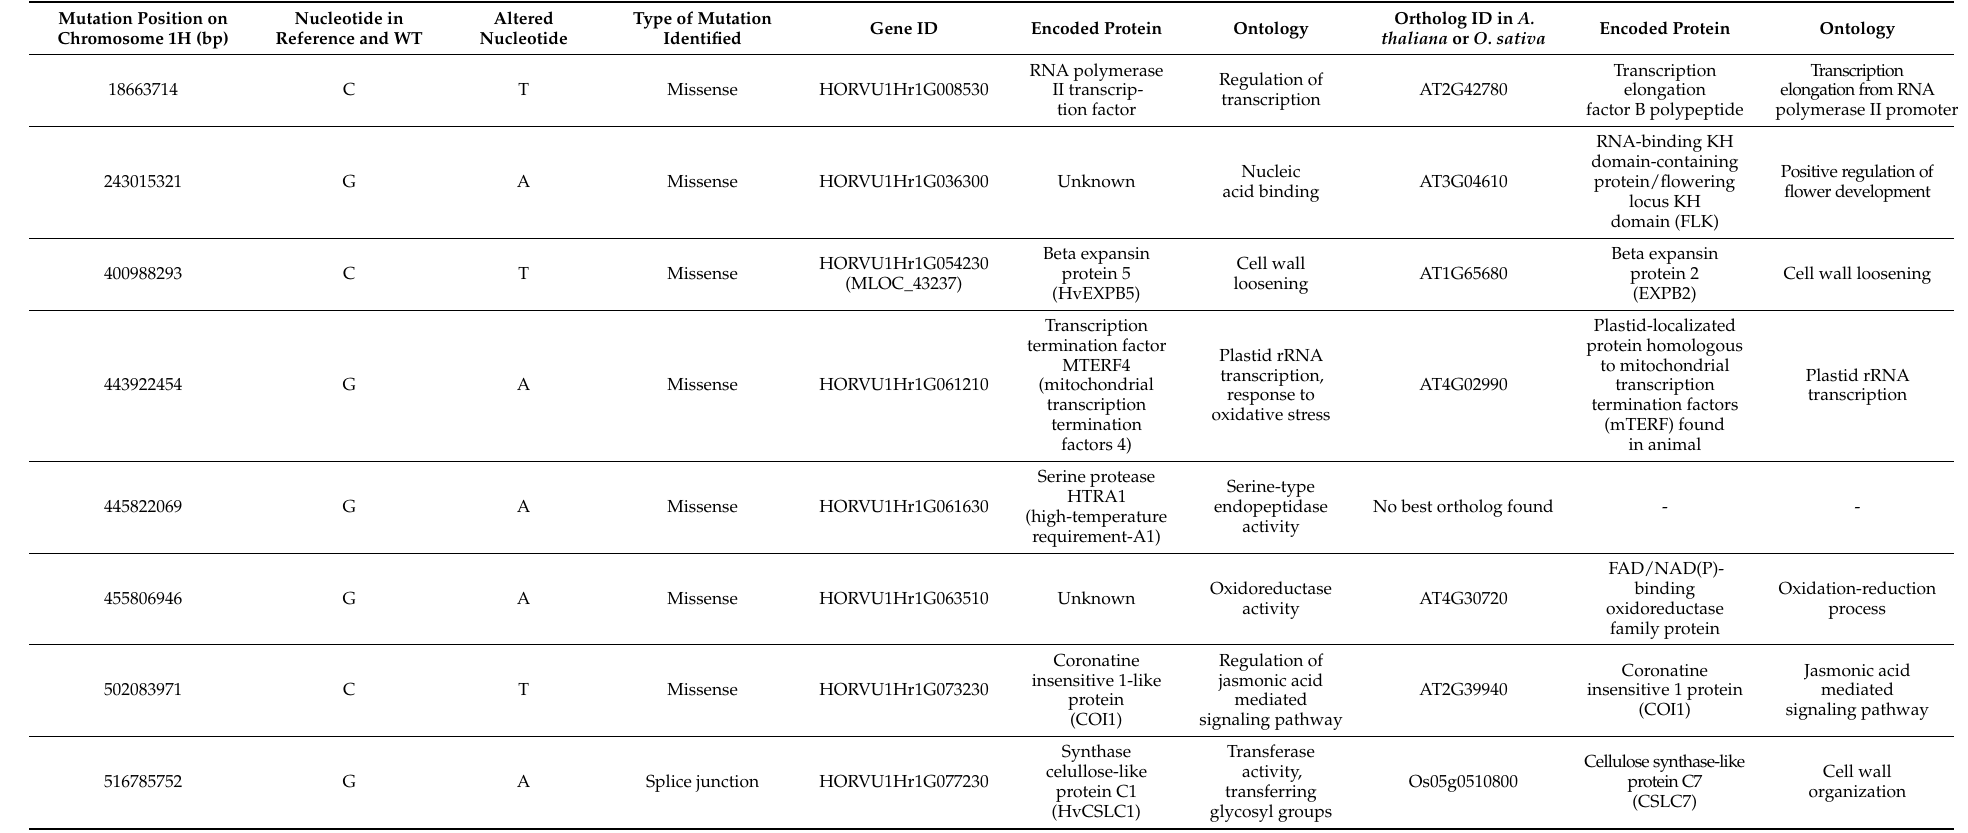
Table 1. Mutations identified on chromosome 1H using whole exome sequencing